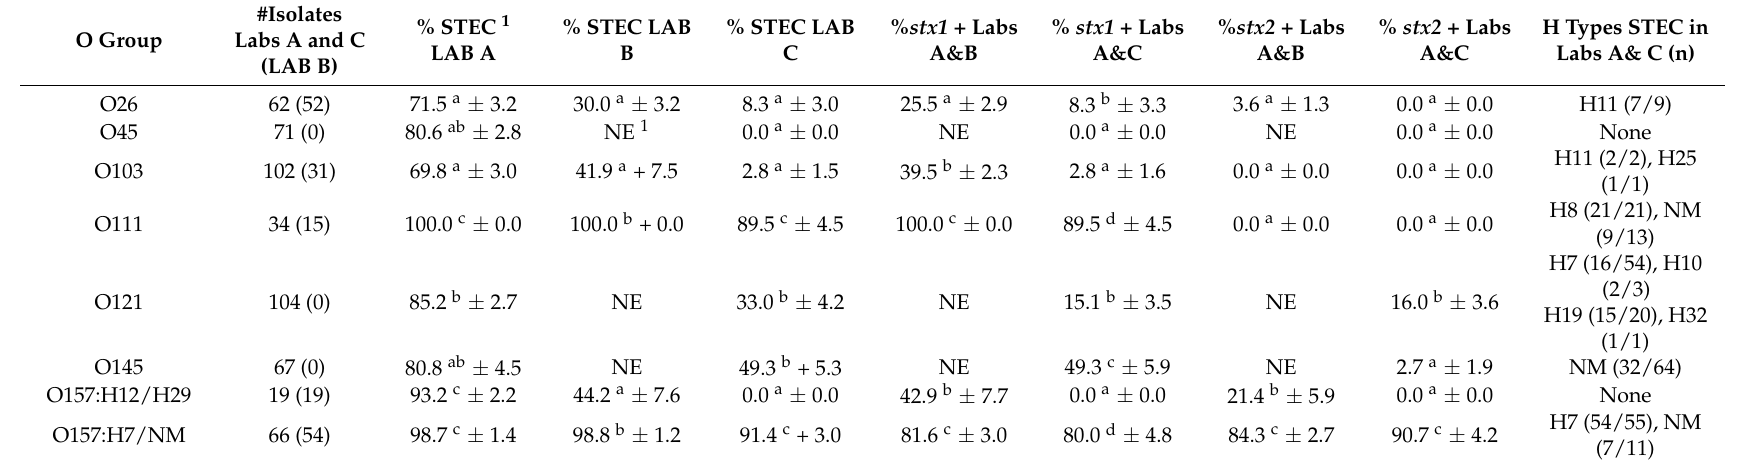
Table 4. Detection of virulence genes at initial isolation (LAB A), LAB B and LAB